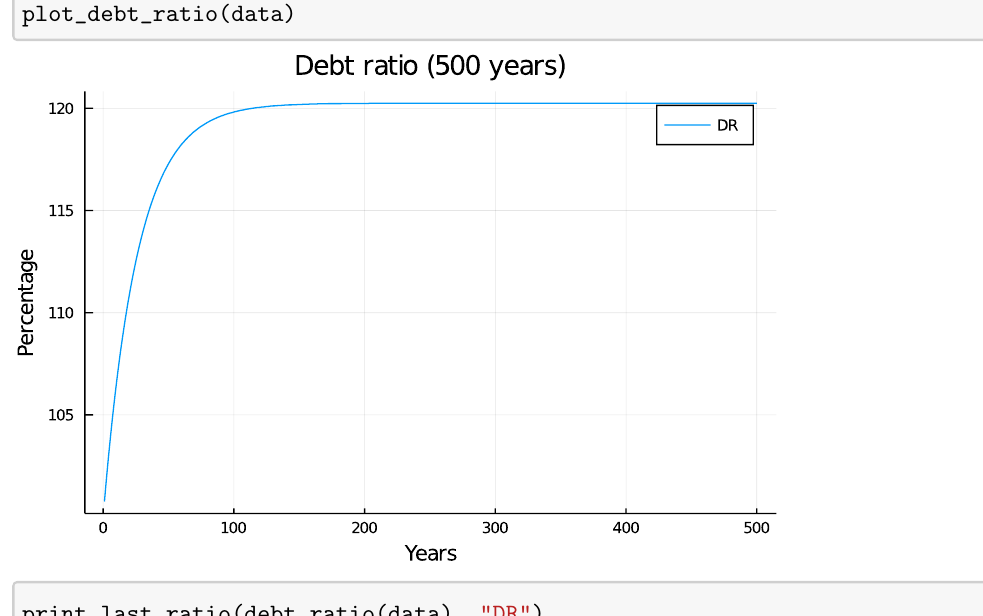
Figure 25. Debt ratio (g = 4.75%, p =